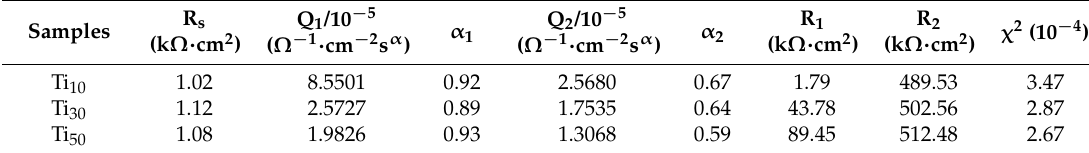
Table 4. Fitting data of electrode impedance spectroscopy (EIS) for the Ti 30 and Ti 50 .